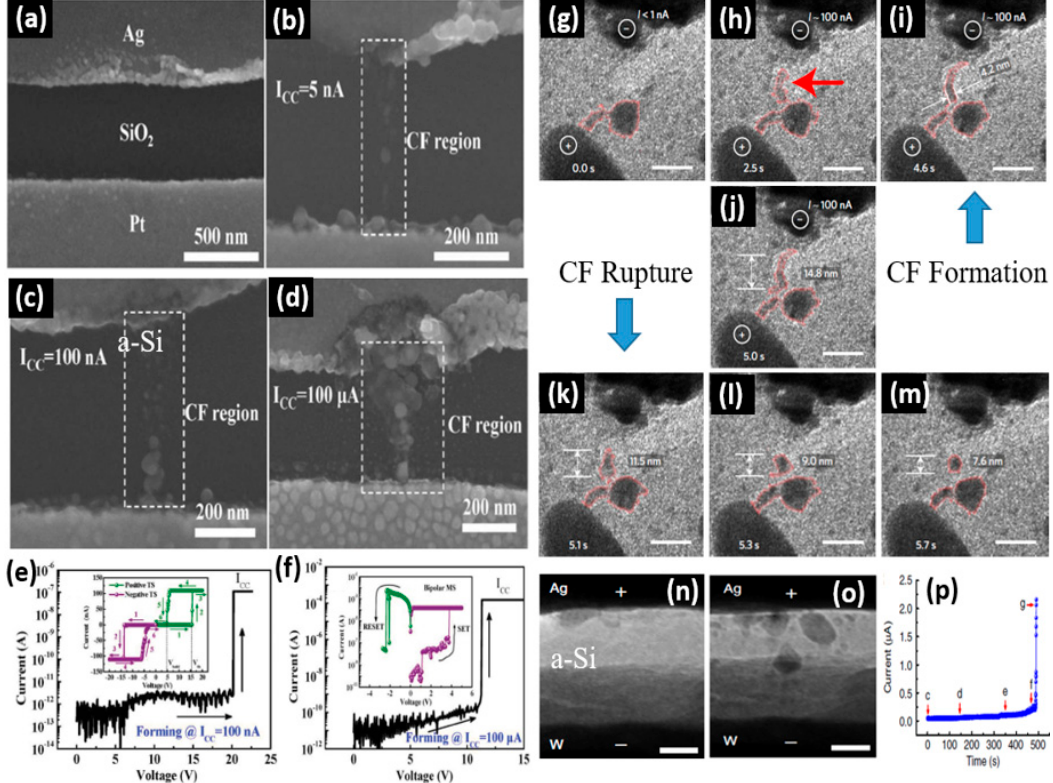
Figure 7. The visualization of formation and rupture of metallic CFs in CBRAMs. ( a ) SEM image of an Ag/SiO 2 /Pt device before the electric bias is applied. The SEM images of the device presenting the morphologies of the CFs at compliance currents of ( b ) 5 nA, ( c ) 100 nA and ( d ) 100 μ A. The corresponding I-V characteristics of the electroforming and subsequent switching at compliance currents of ( e ) 100 nA presenting volatile TS and ( f ) 100 μ A presenting nonvolatile MS . Reprinted from Ref. [20] In situ TEM images of an Au/SiO x N y :Ag/Au device showing the dynamics of CF growth and rupture. ( g – j ) The time sequence of formation of the CF. ( k – m ) The time sequence of the spontaneous self-rupture of the CF. Reprinted from Ref. [51] The TEM images of an Ag/a-Si/W device recorded ( n ) before forming and ( o ) after forming. ( p ) The I – t characteristics of the forming process. Reprinted from Ref.